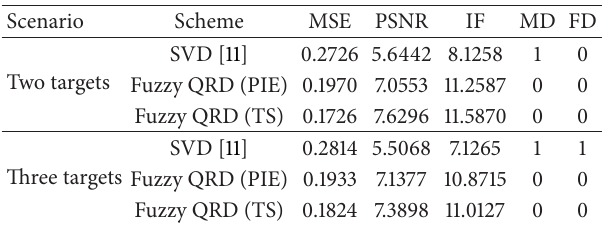
Table 2: MSE, PSNR, IF, MD, and FD comparison.